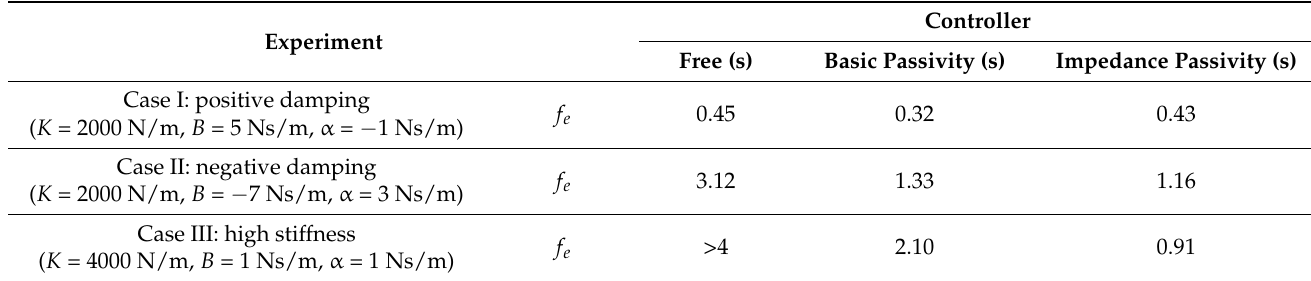
Table 1. Summary of the time needed to reach the stabilizing equilibrium for all